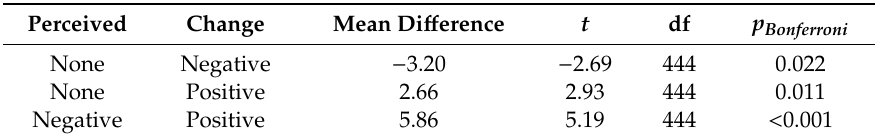
Table 4. Results of the post hoc test considering how, according to parents, the quarantine period changed their relationship with their